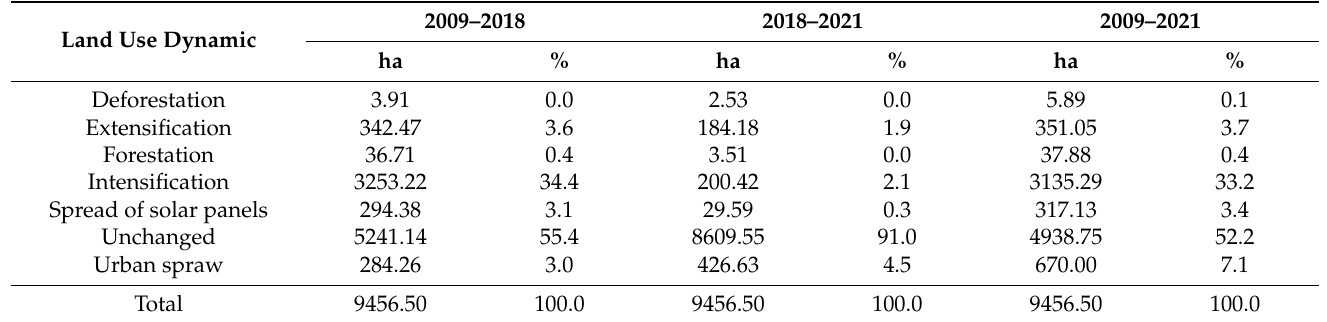
Table 4. Surface of the land use dynamics (in hectares and percentages) for the different time intervals. Land Use